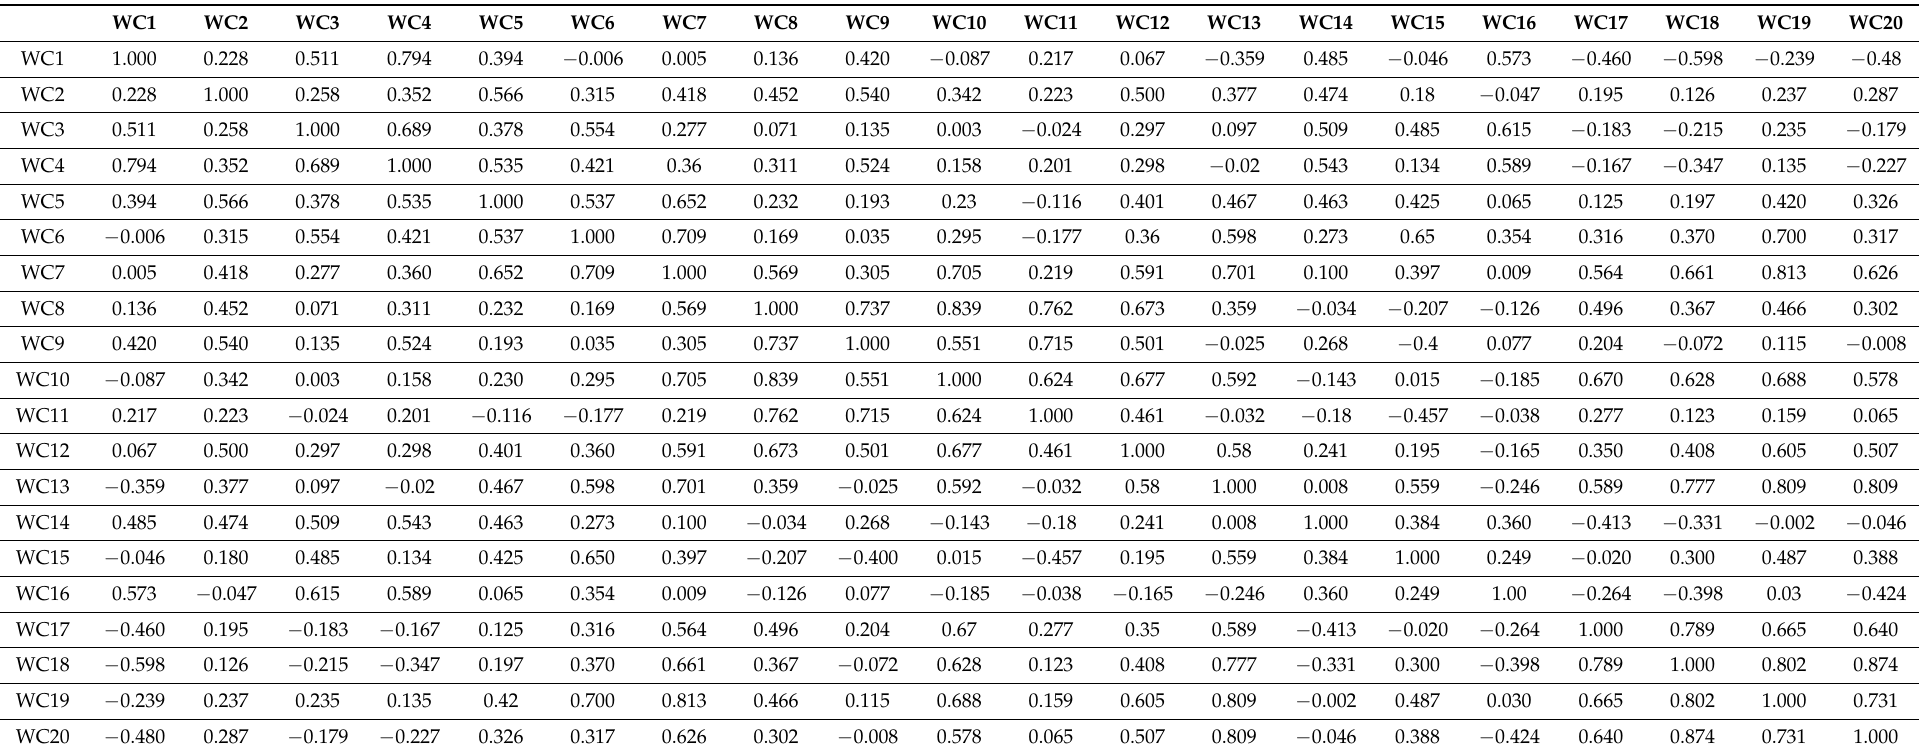
Table 5. Correlation matrix of factor analysis for worker